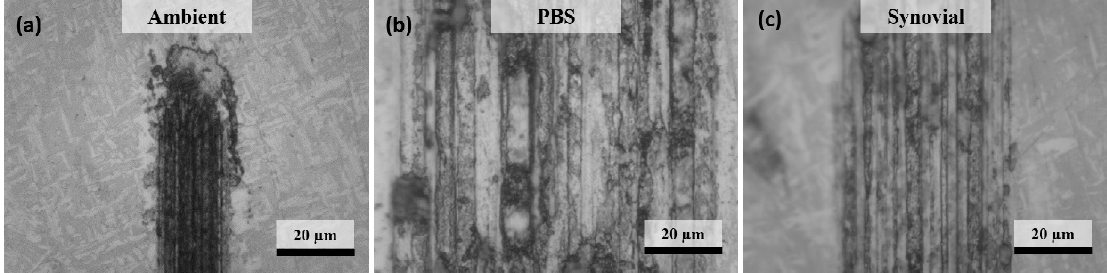
Figure 11. Wear damages on EBM-Z sample after reciprocating sliding contact in ( a ) ambient, ( b ) PBS, and ( c ) simulated synovial solution.